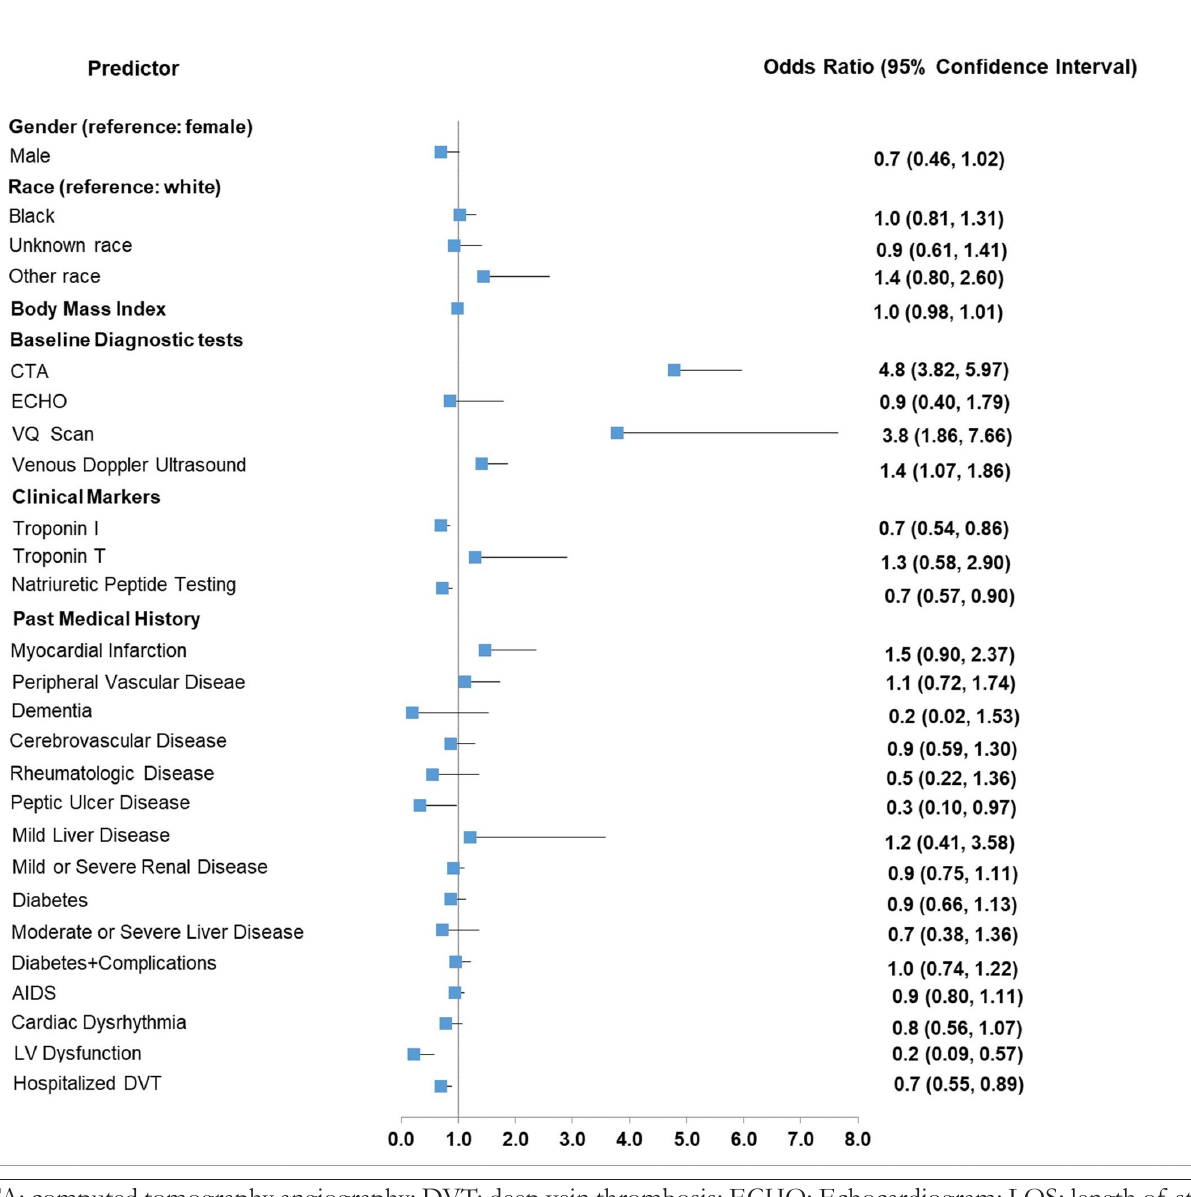
Figure 2. Predictors of Short versus Long LOS among LRPE